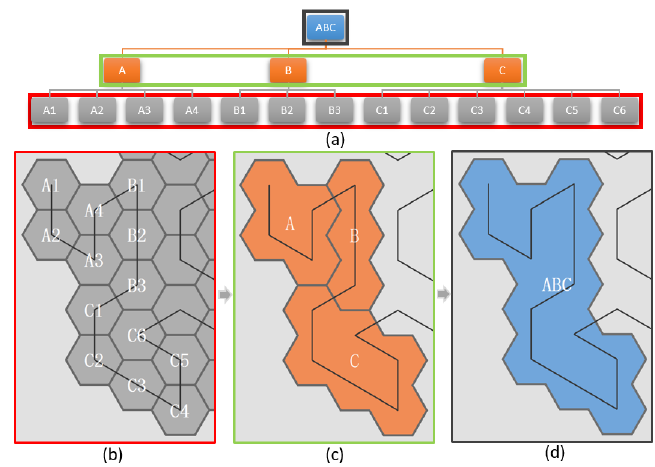
Figure 3. Converting a multi-tree into a corresponding Gosper map: ( a ) multi-tree; ( b ) map regions of the leaf nodes of the multi-tree; ( c ) map regions of the second layer nodes of the multi-tree; ( d ) map region of the top layer node of the multi-tree.